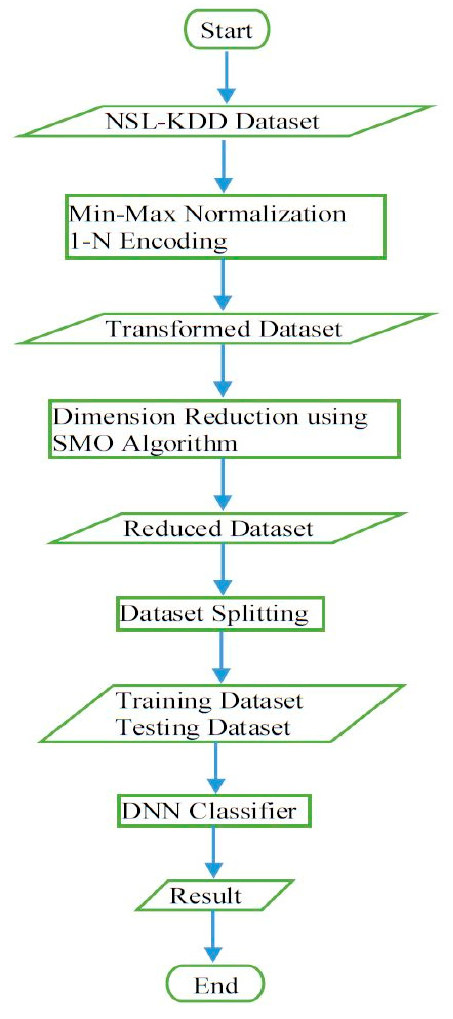
Figure 5. SMO–deep neural network (DNN) Hybrid Classifier for network intrusion detection.